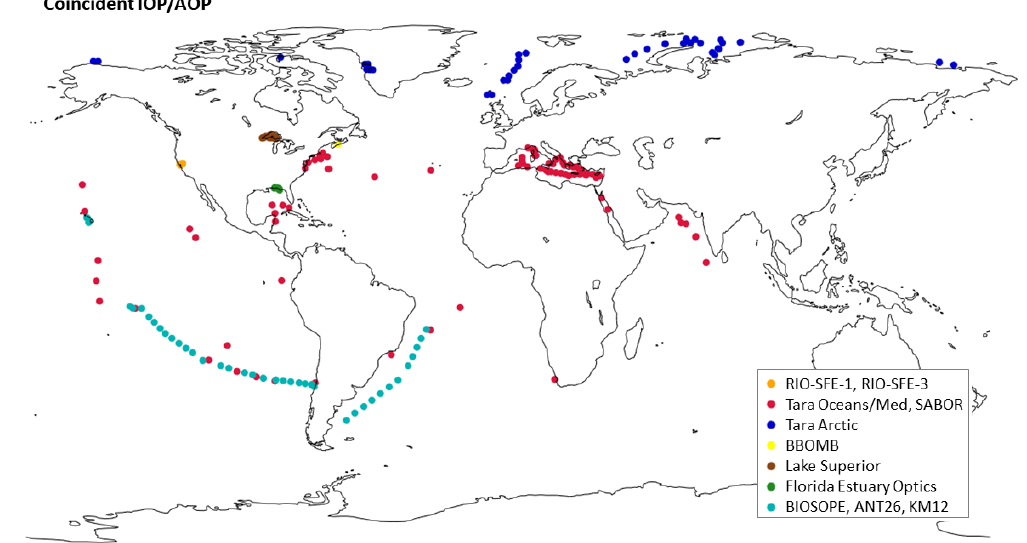
Figure 3. Global geographic distribution of coincident IOP–AOP data by